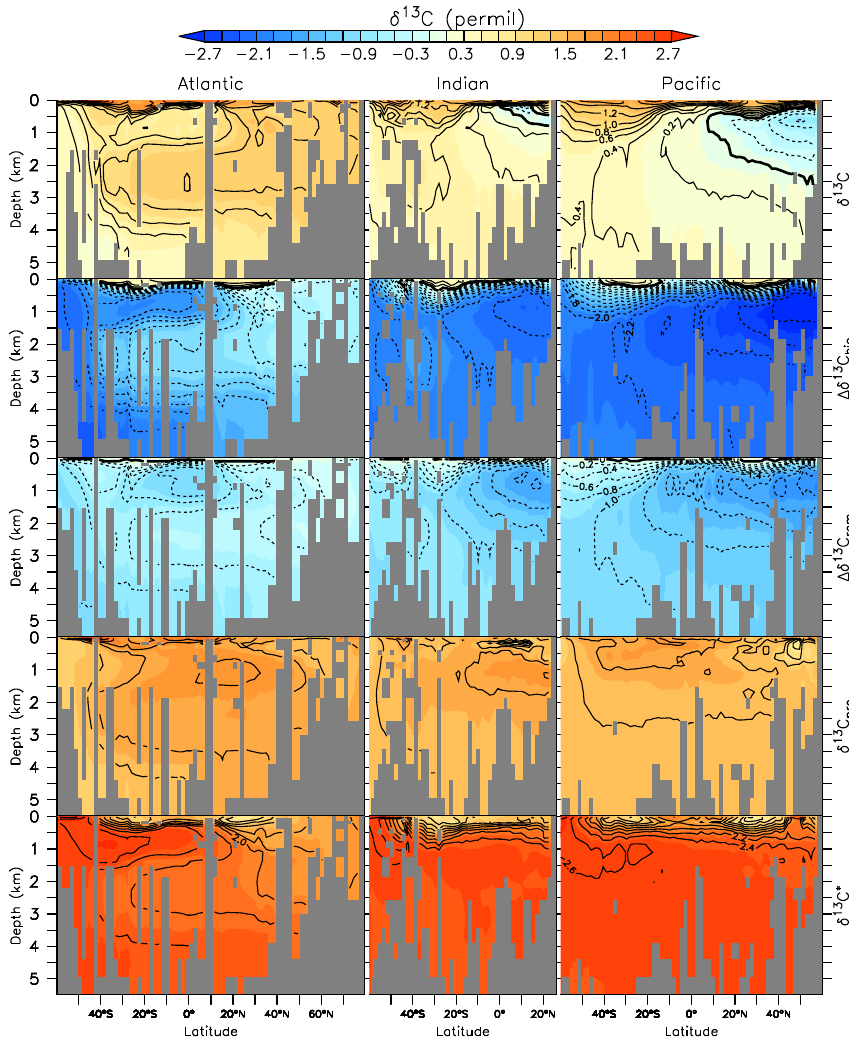
Fig. 12. As Fig. 6 but for the 1990s of model FeL